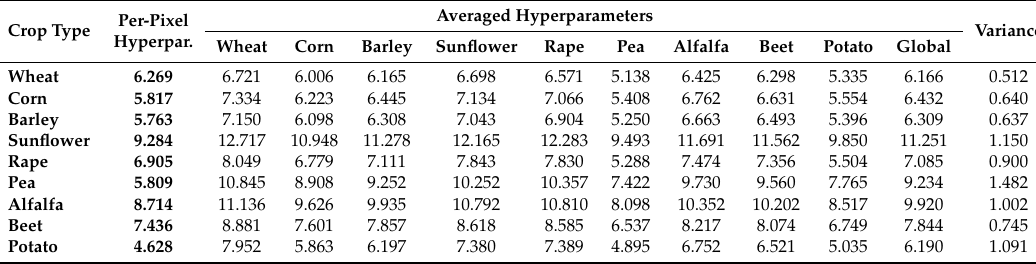
Table 5. Variation in percentage of LAI obtained with precalculated hyperparameters with respect to the original LAI time series (lowest values in bold). Last column exhibits the variance in the percentage. Per-Pixel Crop Type Hyperpar.